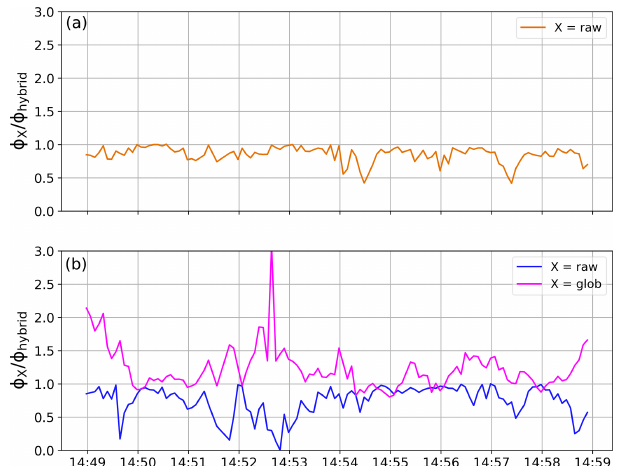
Figure 11. Relative deviations of Guallatiri emission rates shown in Fig. 10. The deviations are plotted as ratios normalised to the re- sults from the proposed method ( flow_hybrid ), both for the crater ( a , no cross-correlation results available) and for the fumarolic emis- sions (b) . The average ratios are 1 . 23 ± 0 . 32% (fumaroles, glob ) and 0 . 85 ± 0 . 12 (crater, flow_raw ) and 0 . 75 ± 0 . 22% (fumaroles, flow_raw ). Again, the latter show a rather strong variability between the